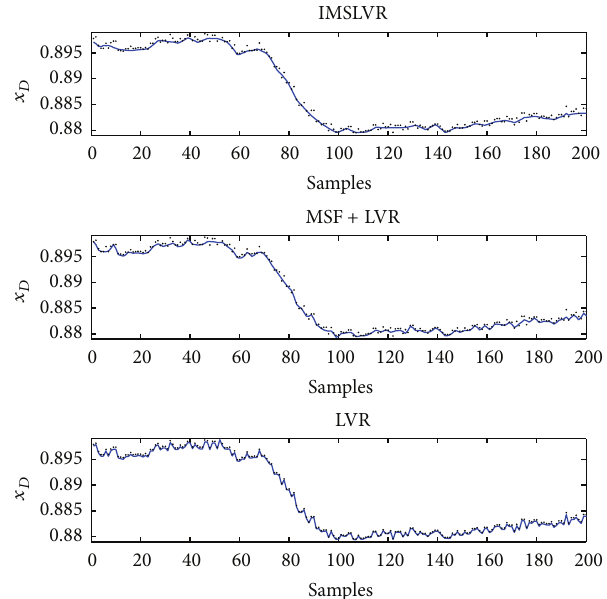
Figure 10: Comparison of the model predictions using the various modeling methods for the experimental packed bed distillation column example (solid blue line: model prediction; black dots: plant